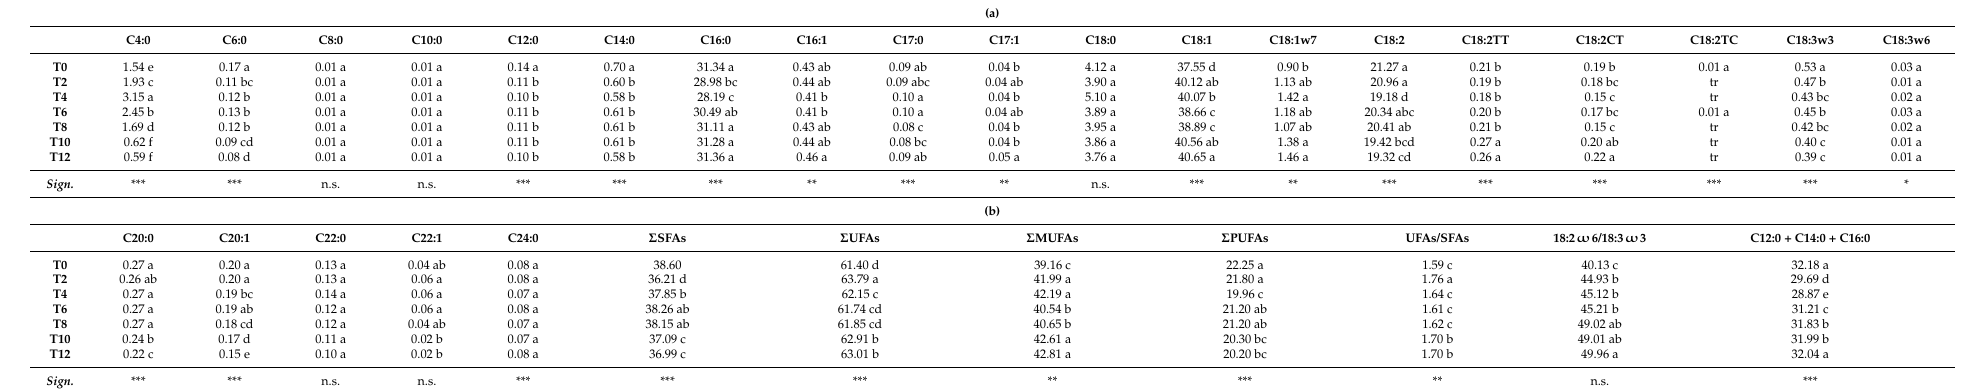
Table 6. Fatty acid methyl esters found in the original recipe Cantuccini. One-way ANOVA, means ± SD (of six replicates) in the same column followed by a different letter are significantly different according to Tukey’s test; *** p < 0.001; ** p < 0.01; * p < 0.05; n.s., not significant.